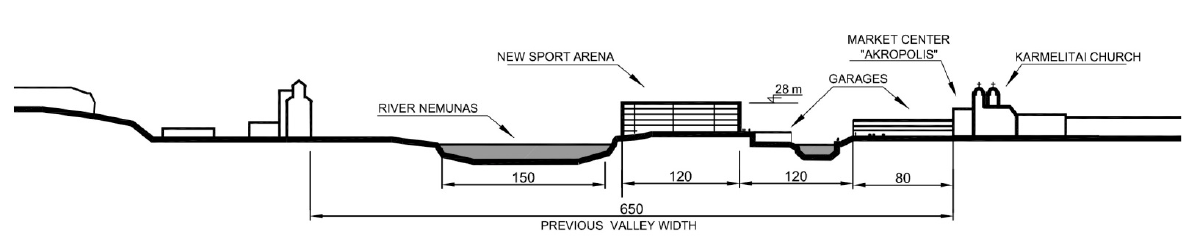
fig. 10. The space of the river nemunas valley in Kaunas has lost its integrity when the multi-storey garages and the sport arena were built; the building constructions have altered the scale of the river space by visually diminishing